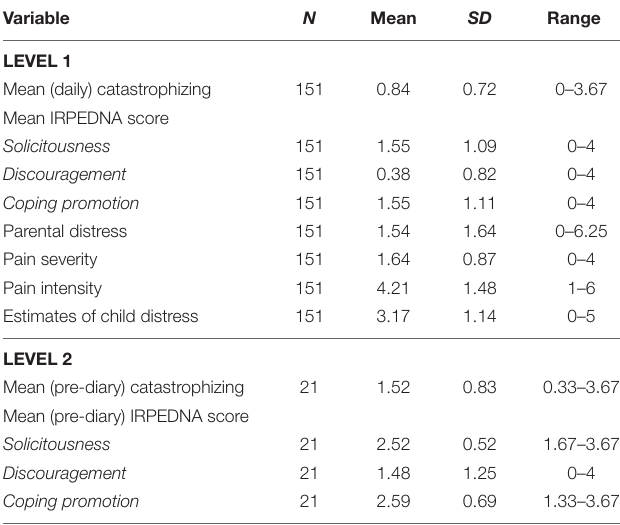
TABLE 3 | Mean, SD, and range of contextual factors for HLM